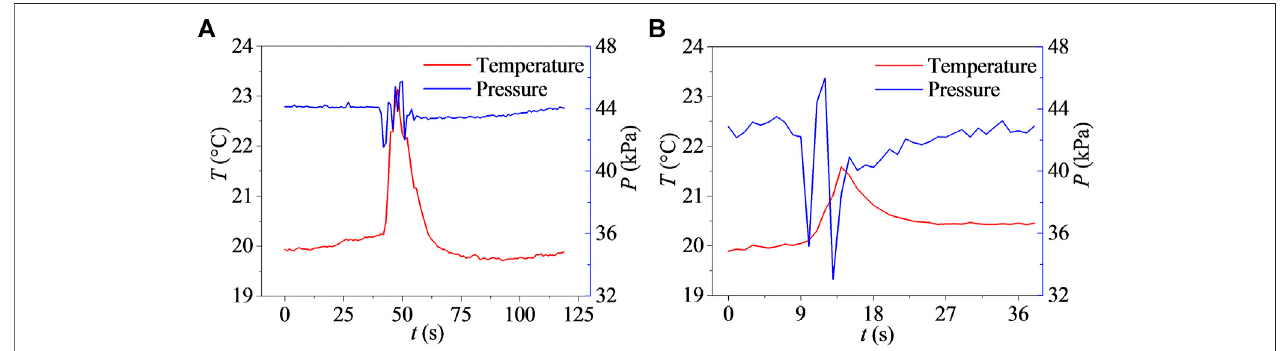
FIGURE 2 | Effect of the initial heat load on the dynamic start-up characteristics: (A) 50 W and (B) 100